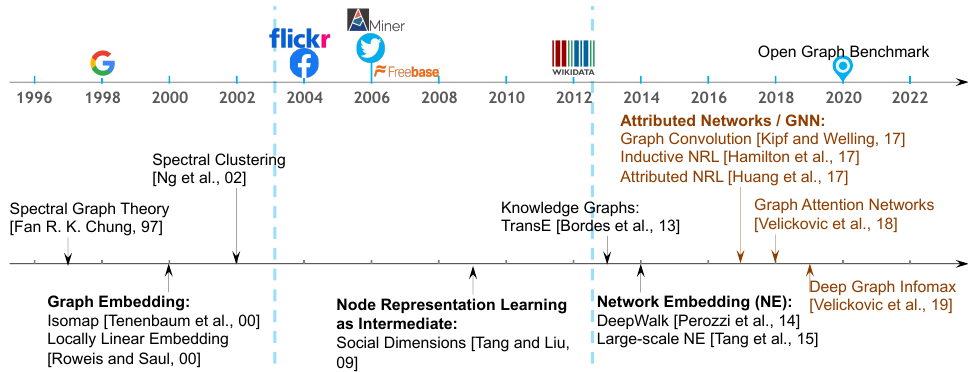
Figure 1. The availability of real-world networks facilitates the development of node representation learning (NRL). We highlight several representative